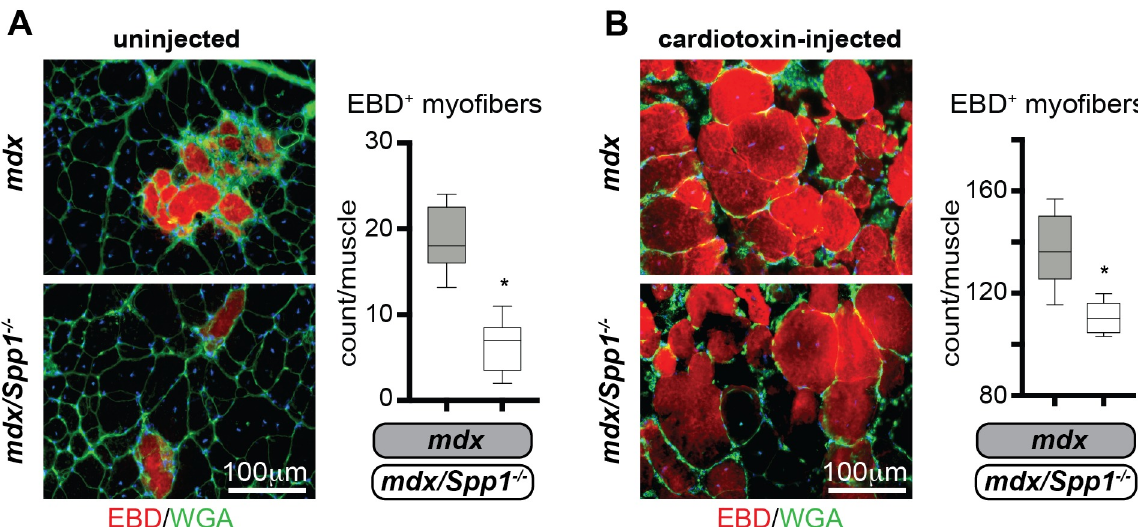
Fig 3. Spp1 ablation in mdx muscle resulted in fewer disrupted myofibers in vivo. A) Three hours after systemic EBD delivery, the number of EBD-positive myofibers (red appearance) was significantly less in mdx/Spp1 -/- TA muscles than in control mdx muscles (left, representative immunofluorescencepanels; right, quantitation). B) Cardiotoxin injectionwas performed in the contralateral muscles, increasing the numberof EBD-positive fibers. After cardiotoxin injury, there were fewer EBD-positive myofibers in mdx/ Spp1 -/- comparedto mdx muscles (left, representative immunofluorescencepanels;right, quantitation). Box plots, Tukey distribution; n = 4 mice/group; * , P < 0.05vs mdx control, unpairedt-test with Welch’s correction.